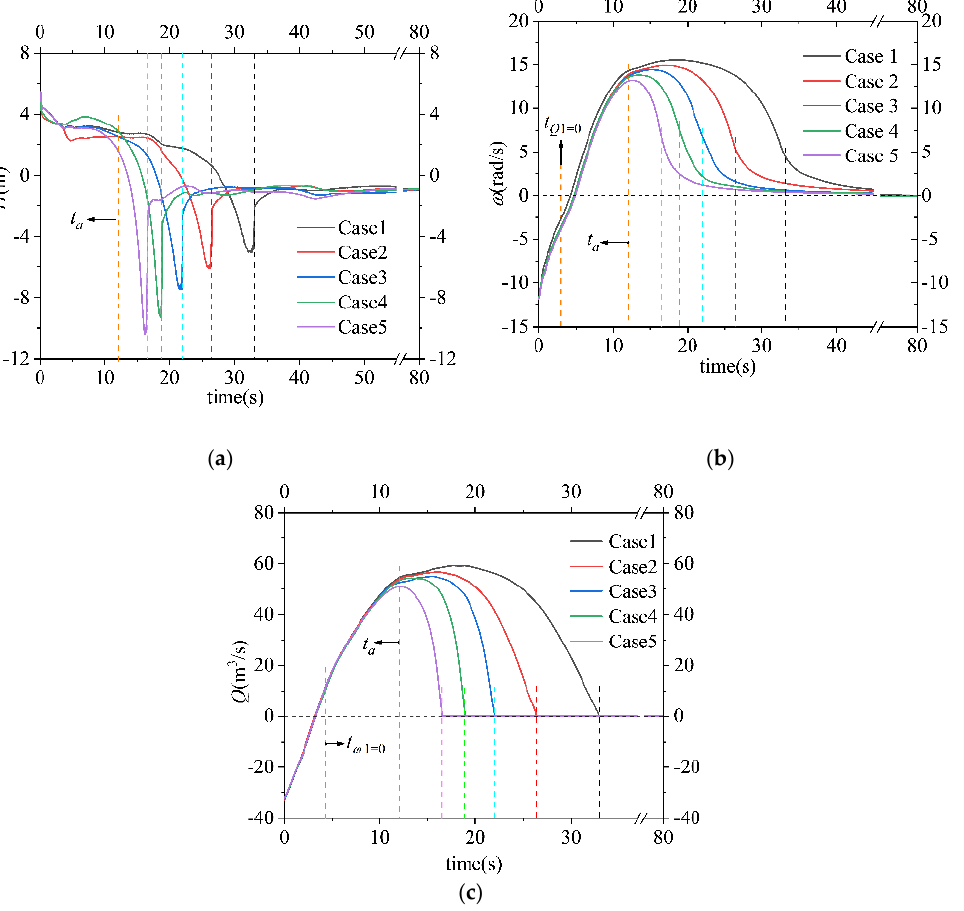
Figure 6. Variation in the hydraulic characteristic parameters during shut-off conditions of the five cases. ( a ) Head; ( b ) runner speed; ( c ) flow rate. cases. ( a ) Head; ( b ) runner speed; ( c ) flow